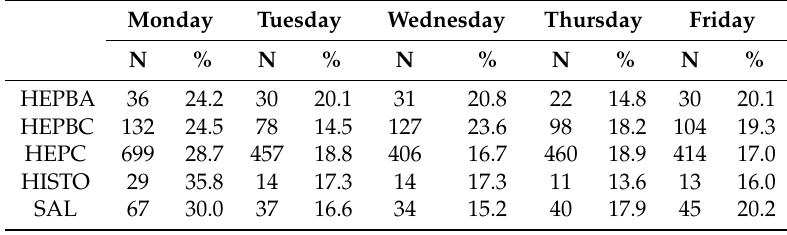
Table 2. Variation in reporting by condition and day of week report received.